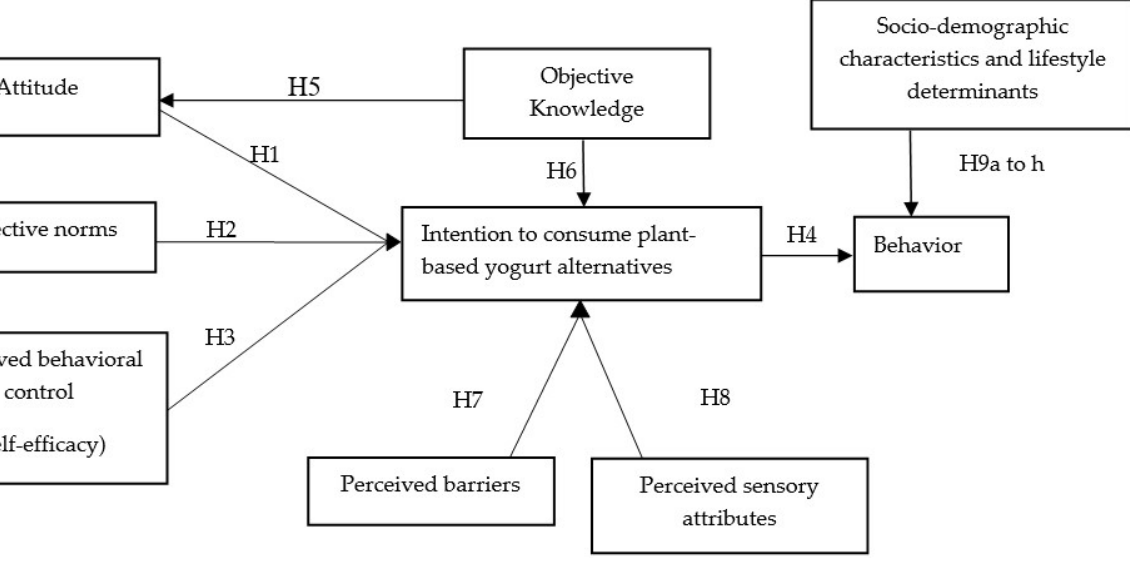
Figure 1. Proposed theoretical